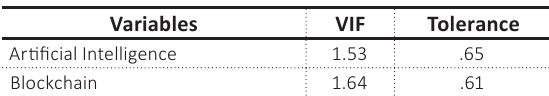
Table 4. Testing the variance inflation factor